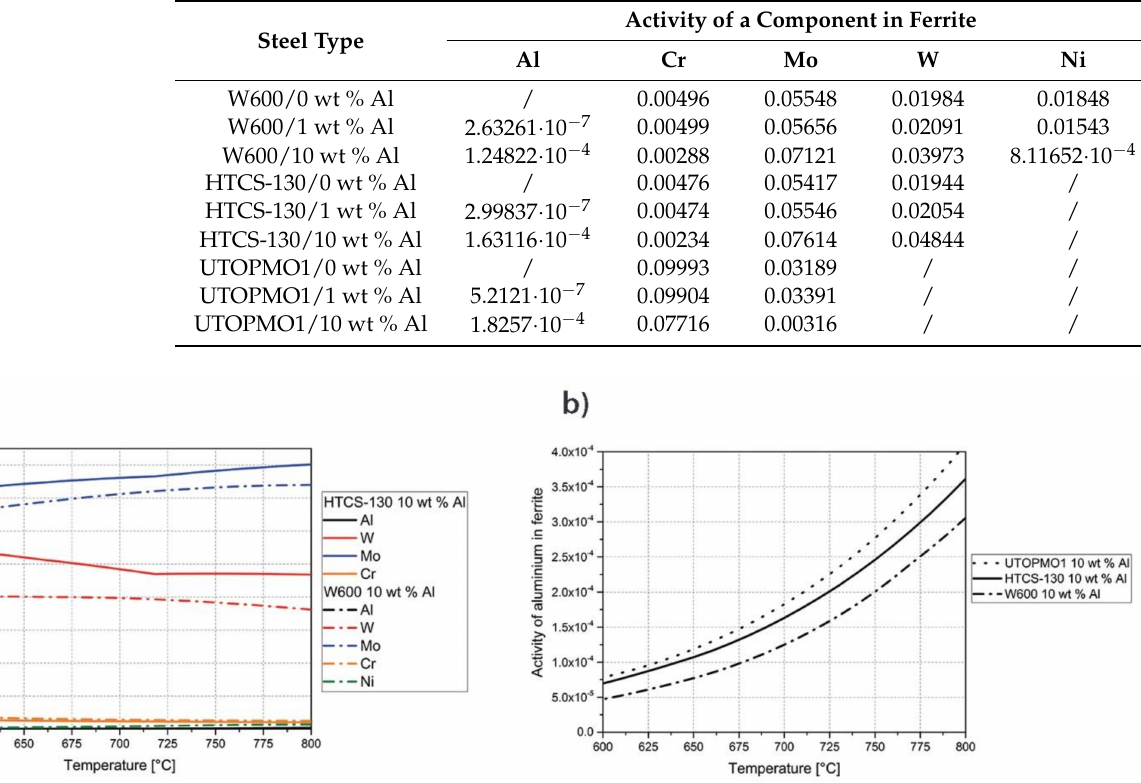
Figure 3. Effect of Ni on the activity of a component in ferrite for W600 and HTCS-130 ( a ) and the activity of aluminum in ferrite for W600, HTCS-130, and UTOPMO1 in which 10 wt % Al was considered ( b